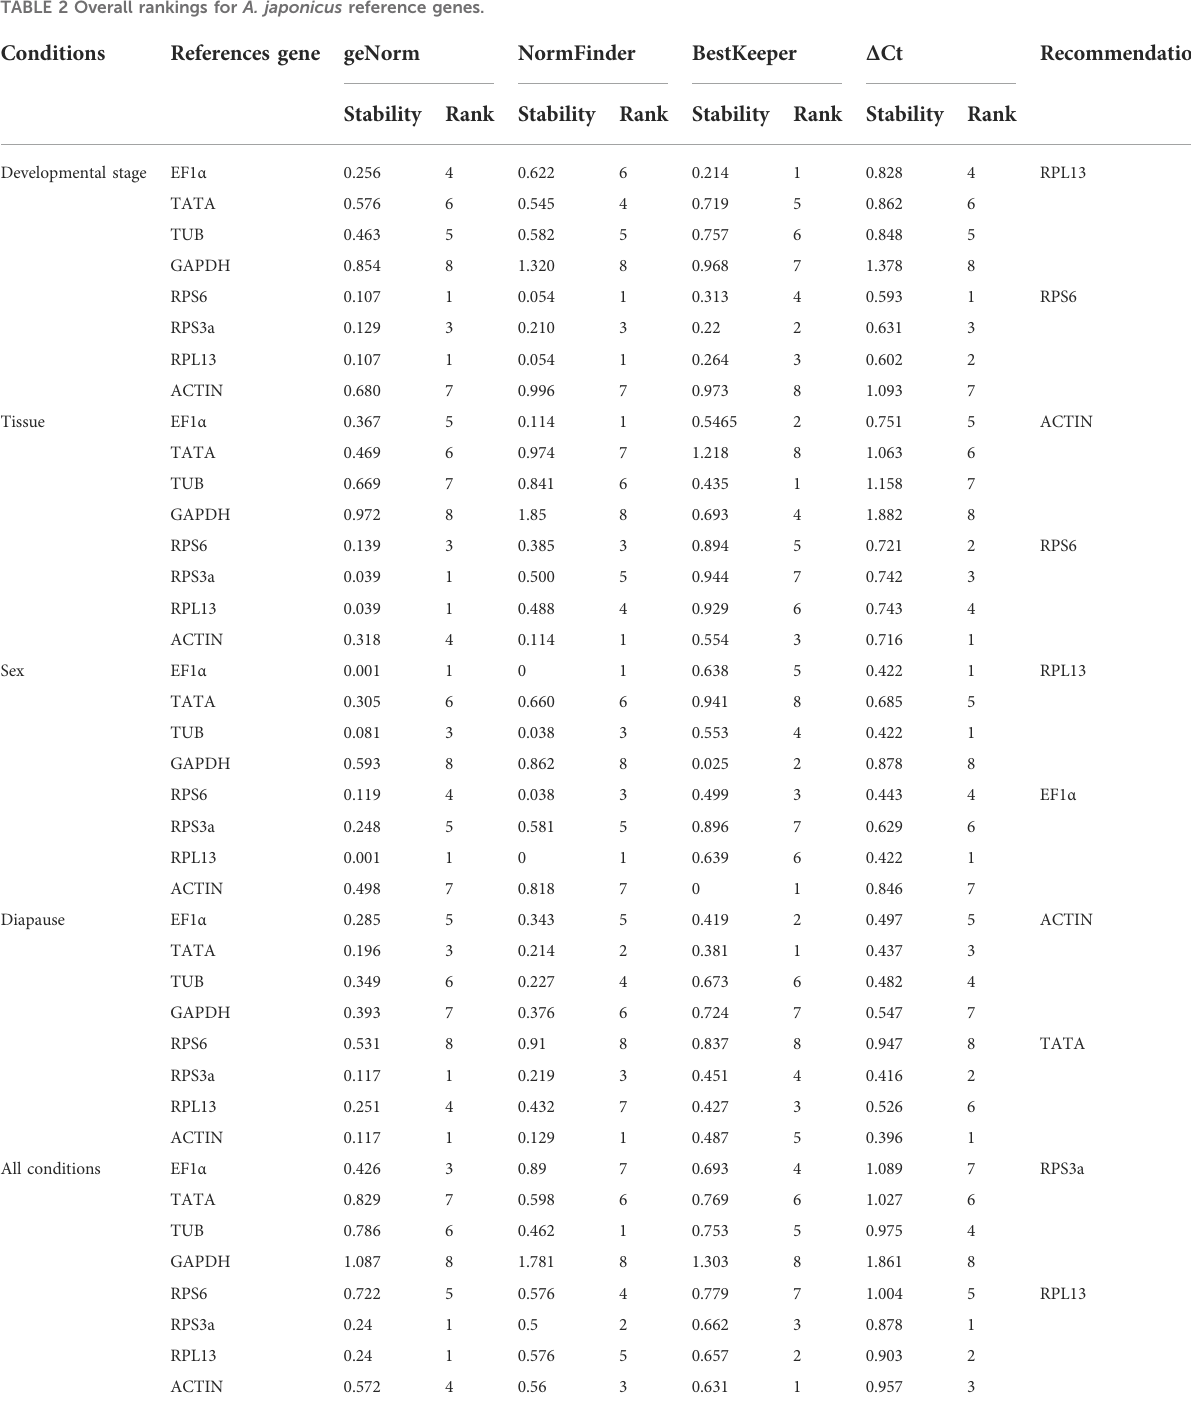
TABLE 2 Overall rankings for A. japonicus reference